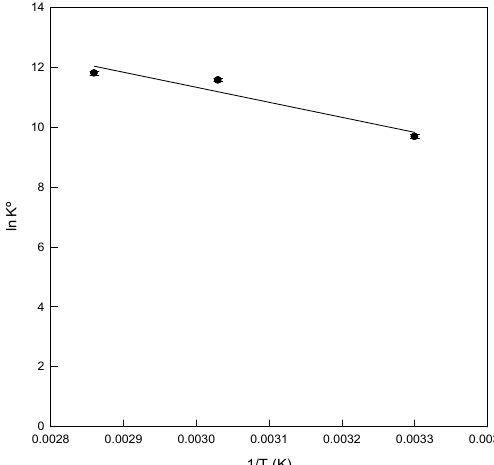
Figure 6. Van’t Hoff plot for the adsorption of Direct Blue 78 onto eggshell at different temperatures. Figure 6. Van’t Ho ff plot for the adsorption of Direct Blue 78 onto eggshell at di ff erent Table 3. Thermodynamic parameters for the adsorption of Direct Blue 78 onto eggshell at different temperatures.